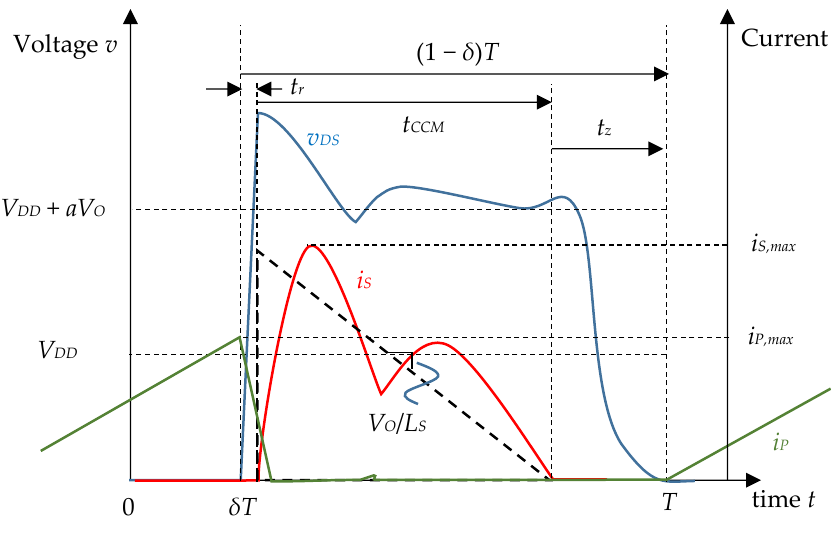
Figure 4. Template of the flyback converter responses.